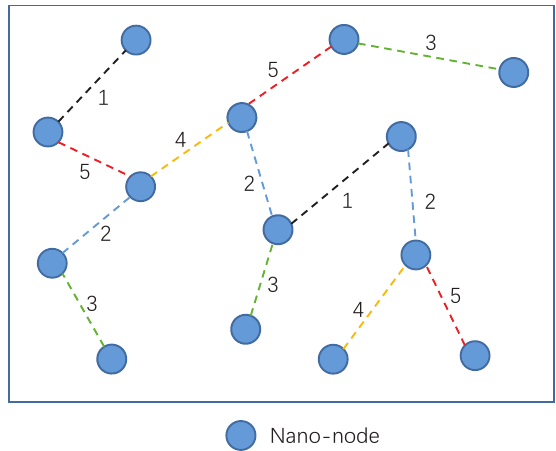
Figure 3. An example of distributed